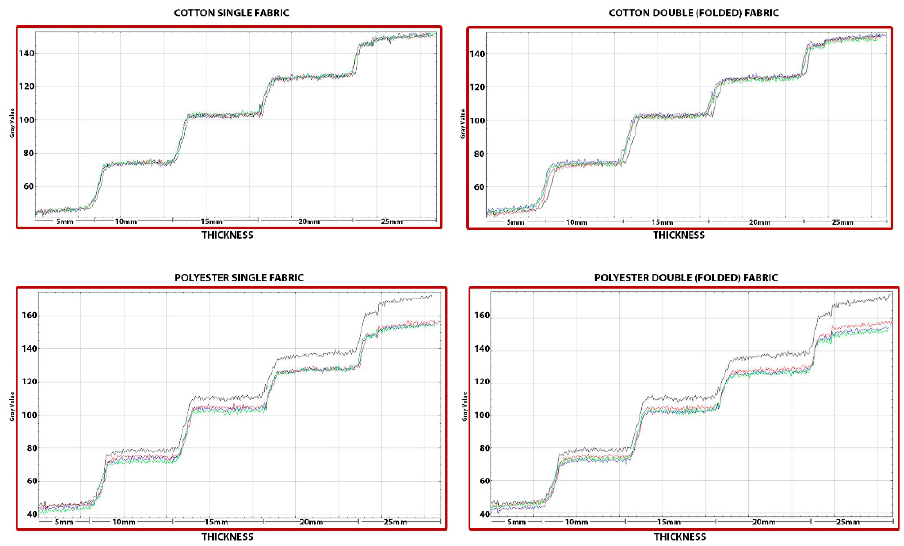
Figure 6. The gray scale values of GO multilayer coated fabrics. Black (UT), red (20L), blue (30L) and green (40L) lines indicate the differences.